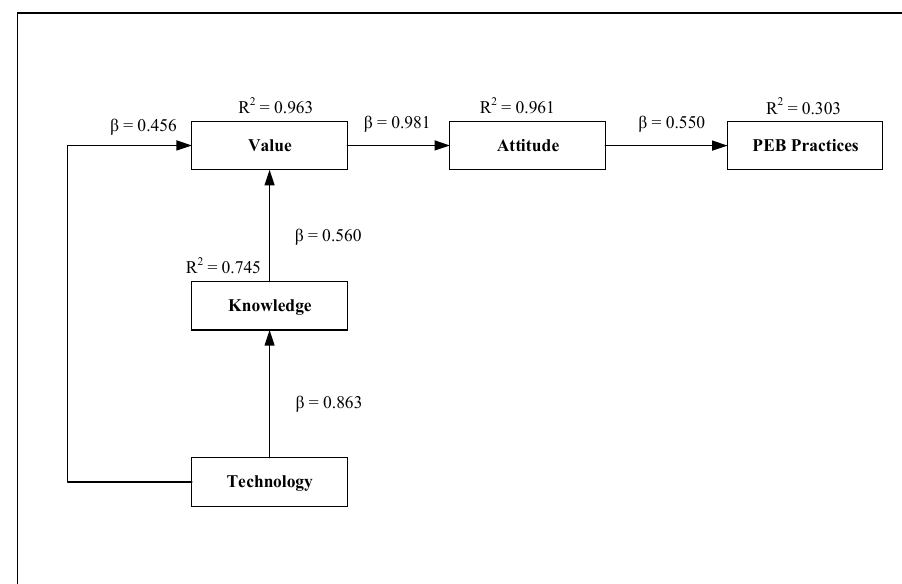
Figure 4. Direct e ff ect strengths ( β ) and Squared Multiple Correlation (R 2 ) values.